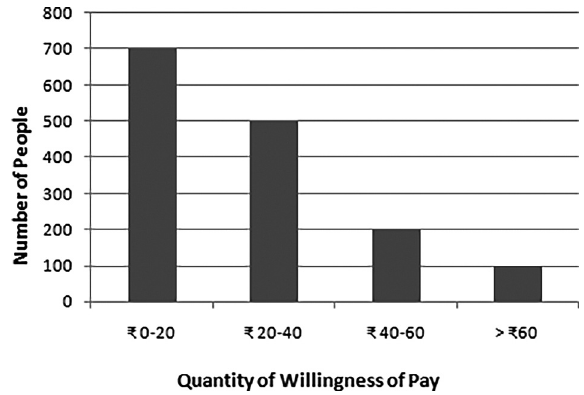
Fig. 2. The number of people willing to